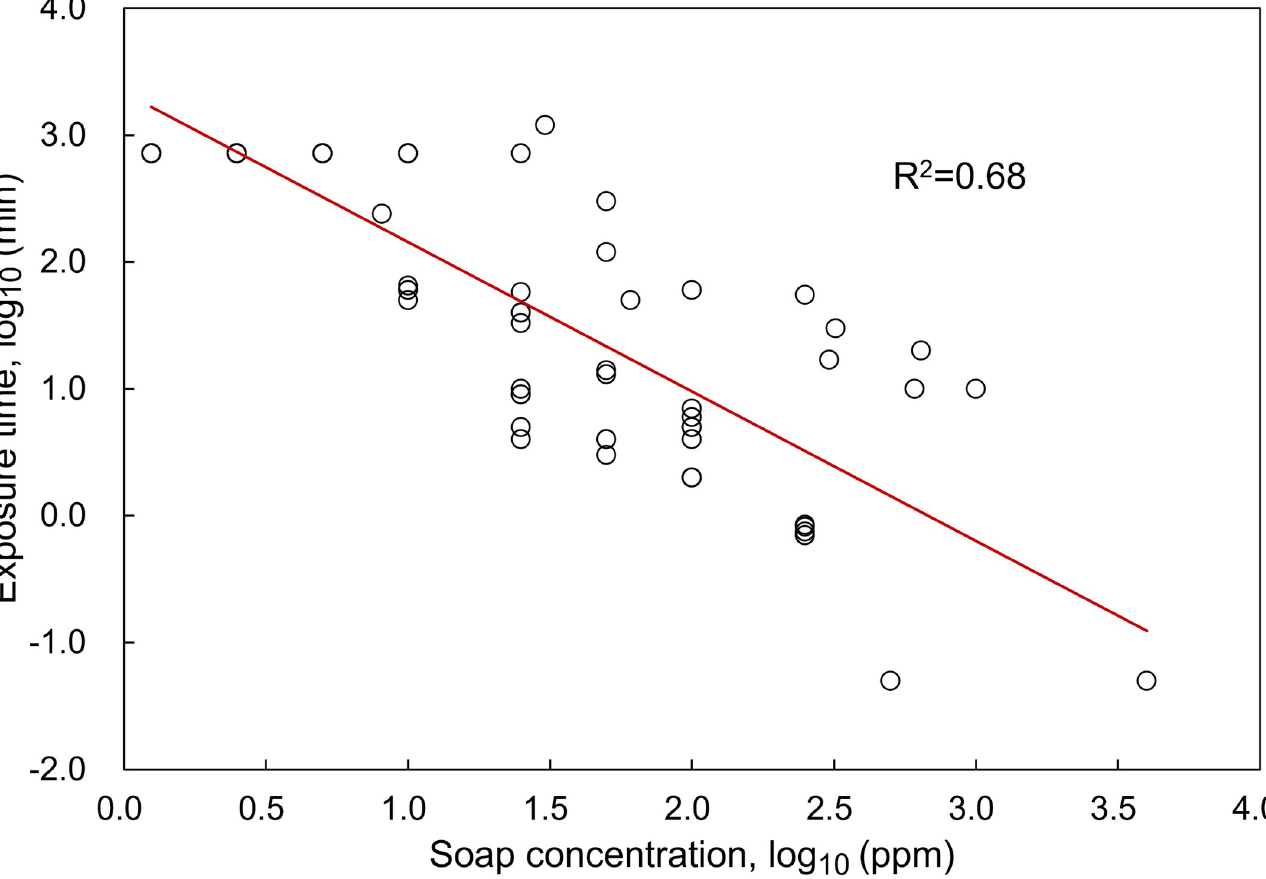
Fig 2. Soap concentrations and exposure times required to achieve 100% cercaria mortality [34,37,38,42,44]. Data are generated from soaps which were tested in five studies. S . haematobium cercariae were used in the study by Lemma [42], while S . mansoni were used in the other four studies. Several assumptions were made as follows: (1) the study by Mimpfoundi & Dupouny stated that the cercariae survived more than 12 hours in some experimental conditions, and therefore it was assumed that cercariae only survived 12 hours in order to include this research [38]; (2) LC 90 was used as the dose for 100% mortality in the study